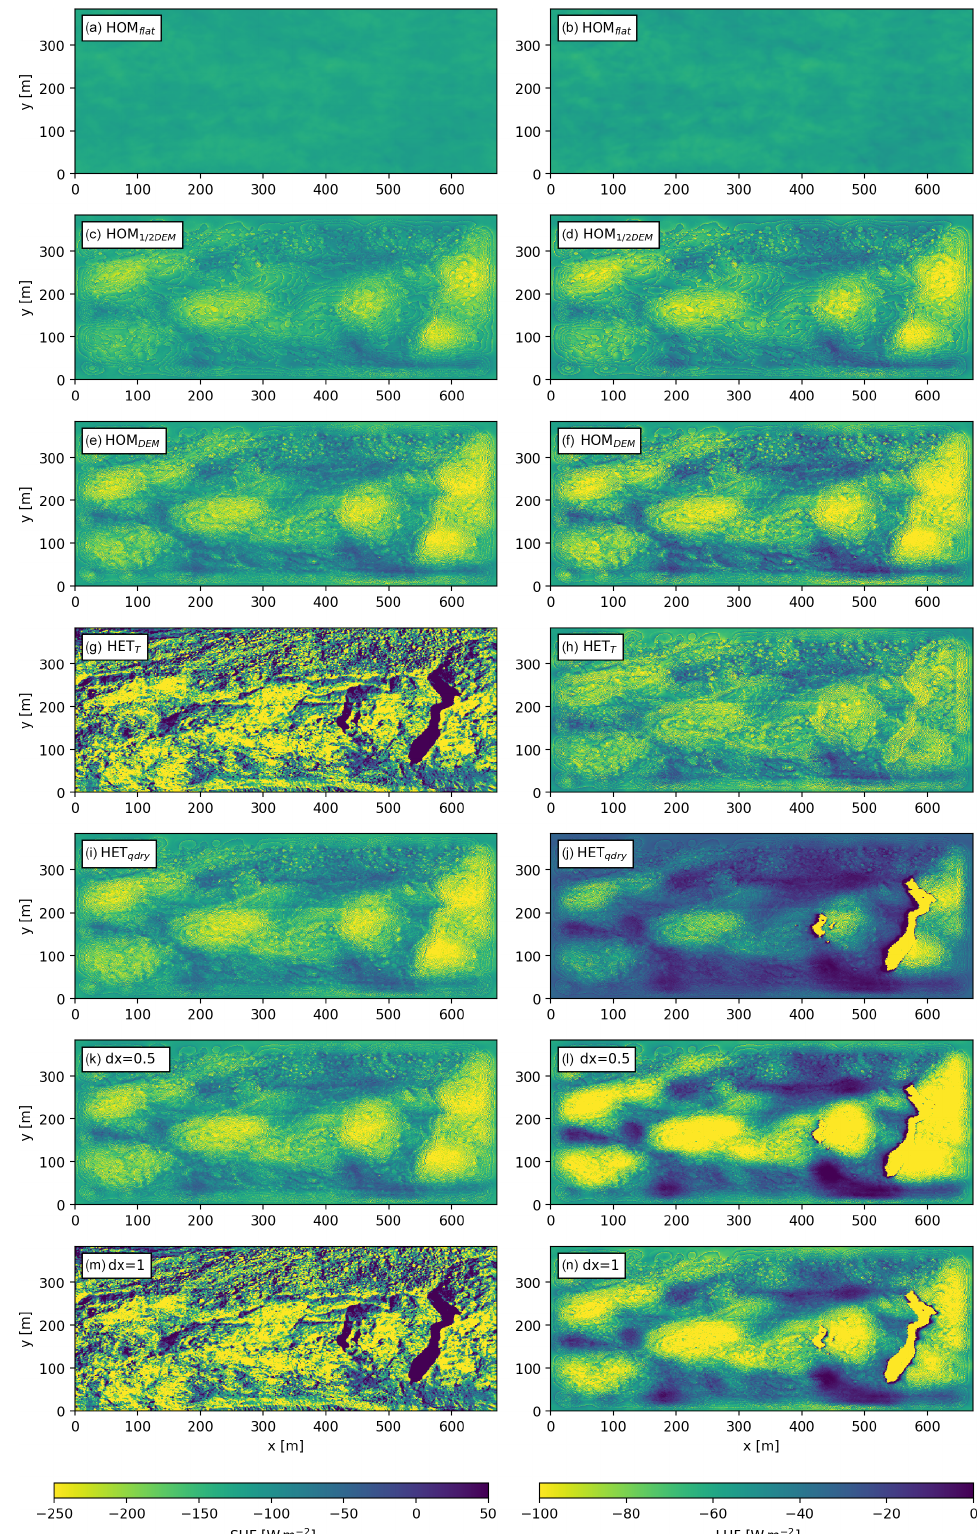
Figure 3. Two-dimensional plots of average variables SHF (left panels) and LHF (right panels) for each experiment in the same order as presented in Table 1 (rows). Elevation increases from left to right and the main wind direction is from left to